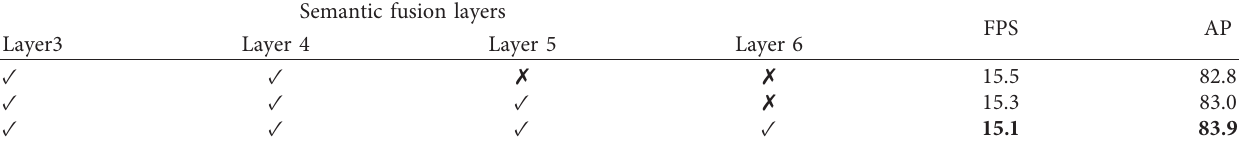
Table 5: Effects of different fusion layers for detection accuracy on FTSD-IEFSSD.